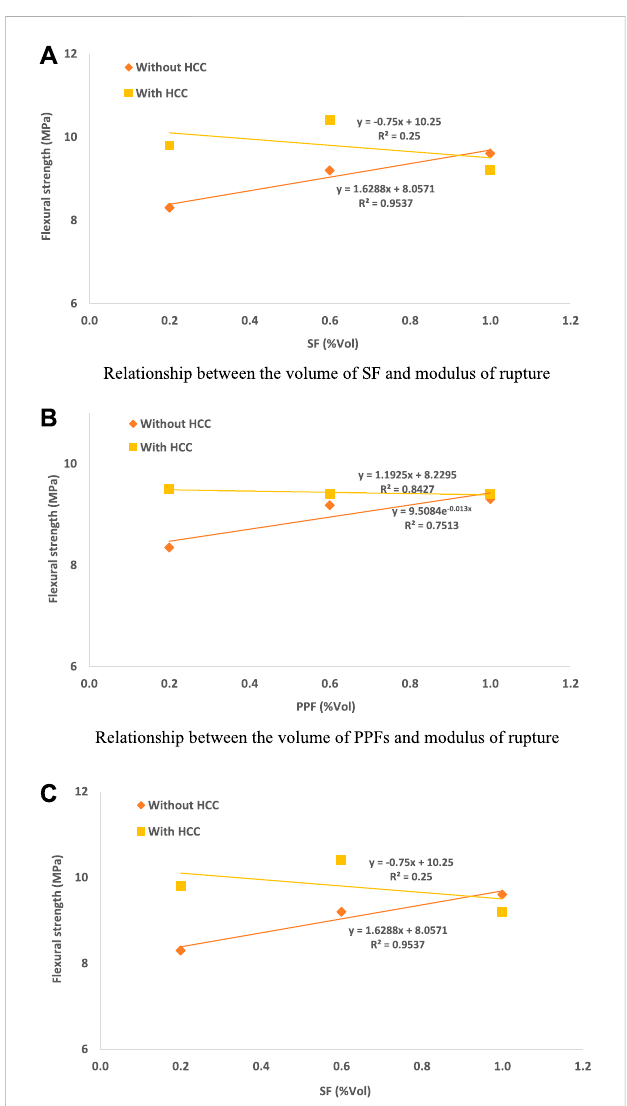
FIGURE 4 Relationship between the volume and modulus of rupture of SF, PPF, and DPF. (A) Relationship between the volume and modulus of rupture of SF. (B) Relationship between the volume and modulus of rupture of PPF. (C) Relationship between the volume and modulus of rupture of